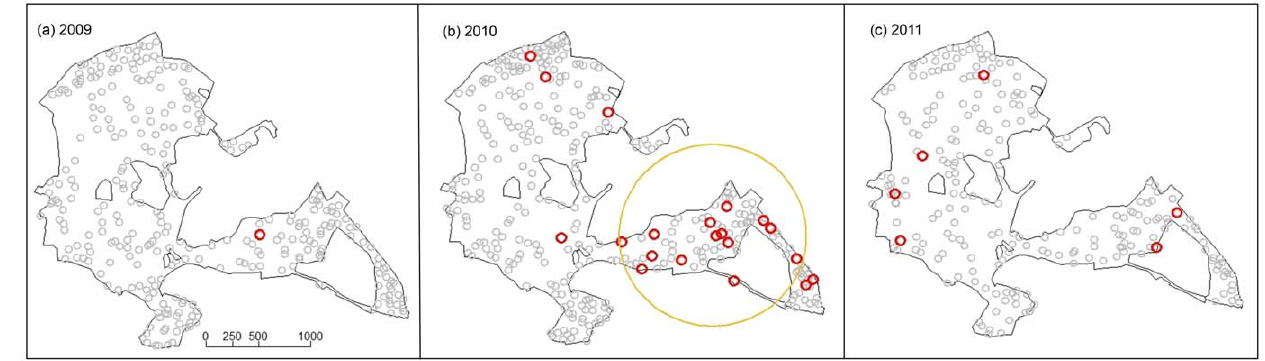
Figure 3. Locations of diseased (red circles) and healthy (grey circles) great tits captured in Wytham Woods. Spatial analyses were conducted for the (a) 2009, (b) 2010, and (c) 2011 breeding seasons. The location and spatial extent of the single statistically significant pox cluster identified in 2010 by the SatScan spatial cluster analysis is shown by an orange circle (log-likelihood ratio=10.55, relative risk=7.93; P=0.01).